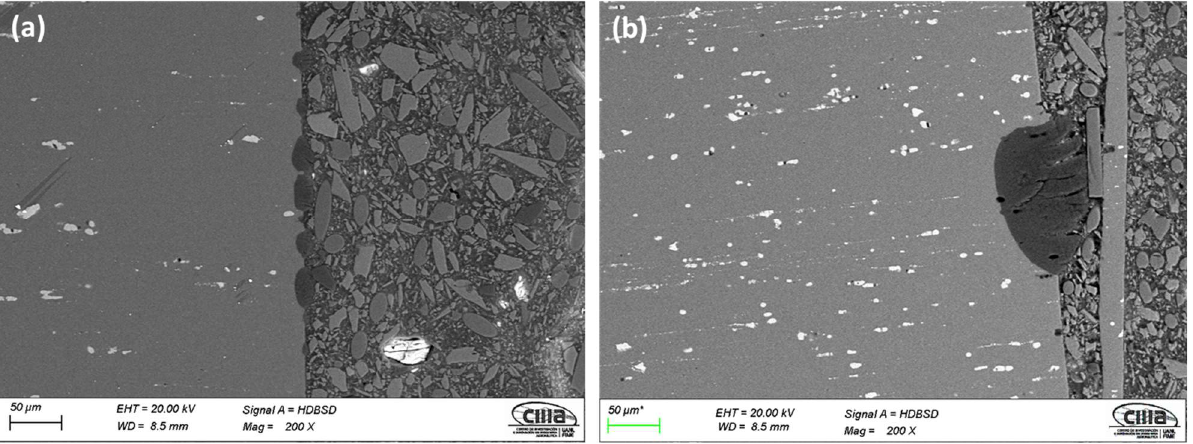
Figure 5. SEM-BES cross-section micrographs of anodized samples of AA2024: ( a ) 3A C1M and ( b ) 4.5A C1M.